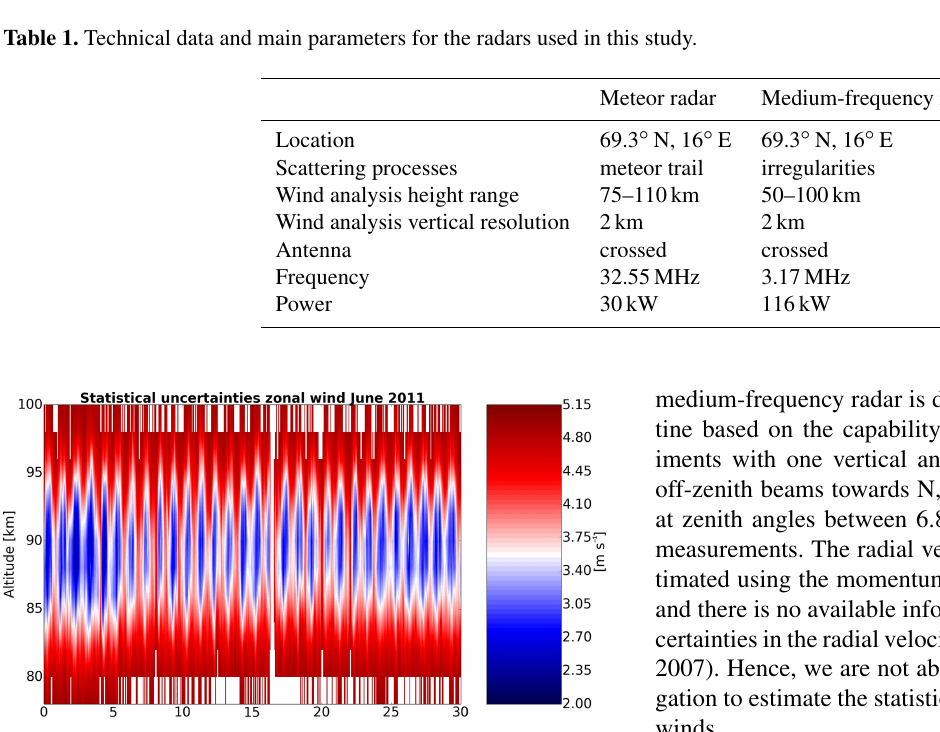
Figure 1. Statistical uncertainties for the hourly zonal wind of the MR for June